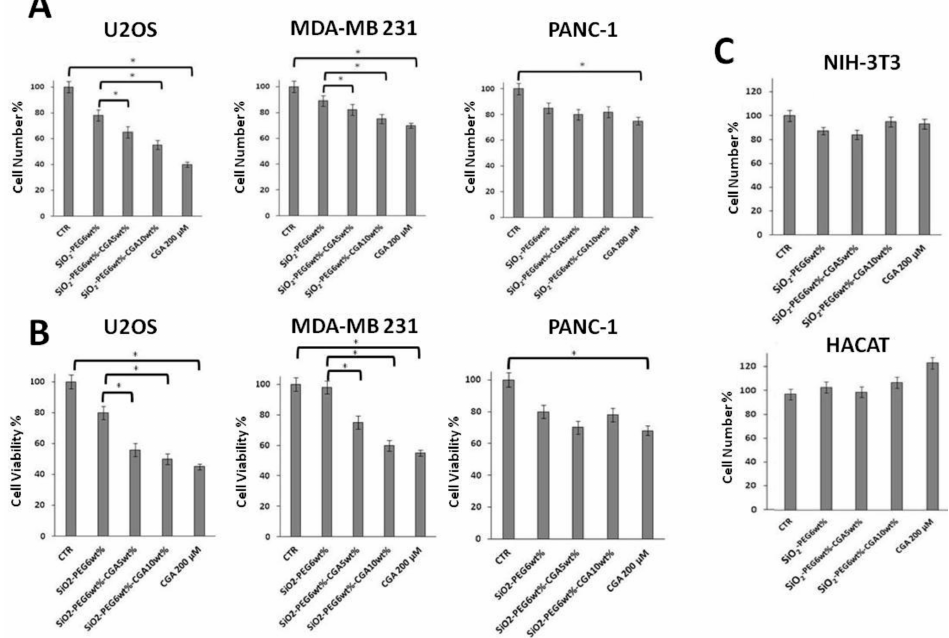
Figure 6. A representative XRD of SiO 2 /PEG 6wt% /CGA 10wt% soaked in SBF solution for 21 days.